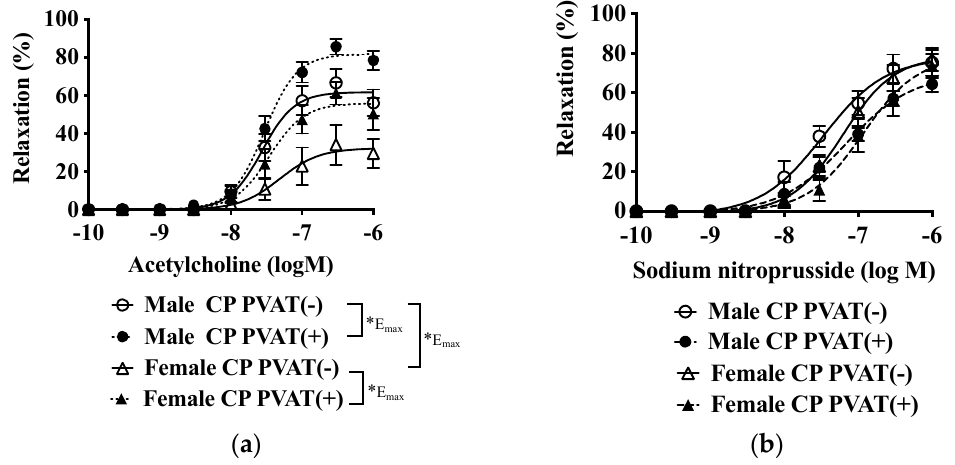
Figure 2. Vascular relaxation in response to acetylcholine ( a ) and sodium nitroprusside ( b ) in renal arteries with or without perivascular adipose tissues [PVAT (+/ − )] of male and female SHR/NDmcr- cp rats (CP) at 23 weeks of age. Arterial rings were submaximally contracted by phenylephrine to determine the acetylcholine and sodium nitroprusside dose–response curves. Data are expressed as means ± SEM. n = 9 rats/group. * p < 0.05. Statistical comparisons of means between groups were performed using a two-way ANOVA followed by Bonferroni post hoc test. Table 3. Relaxation and contractile response in renal arteries with (+) or without ( − ) perivascular adipose tissue (PVAT) from SHR/NDmcr-cp rats (CP).